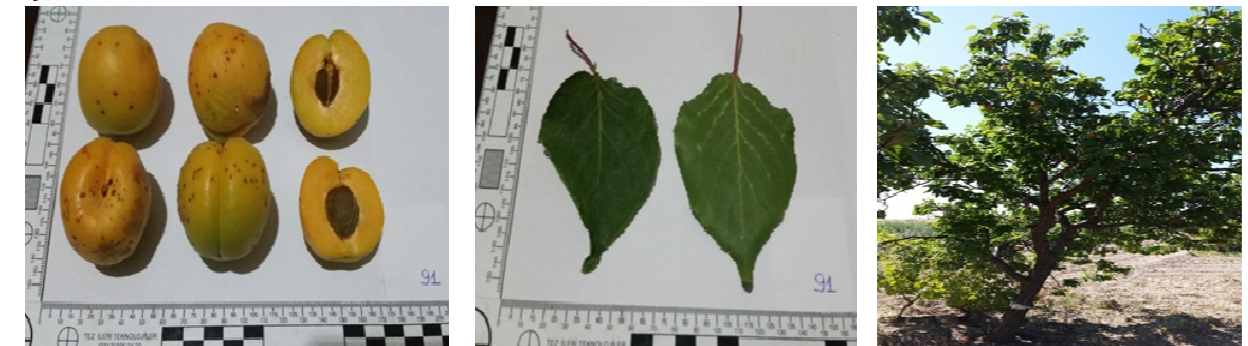
Fig. 2. Fruits, leaves and tree of genotype